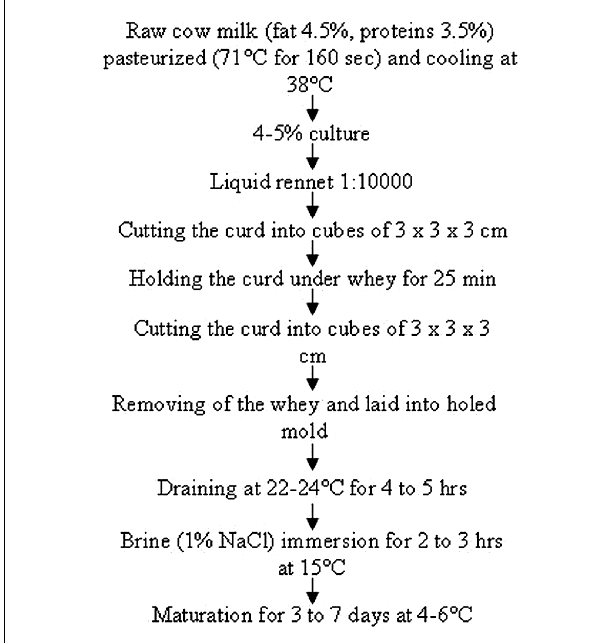
FIGURE 1 | Schematic representation of the Crescenza manufacturing process.